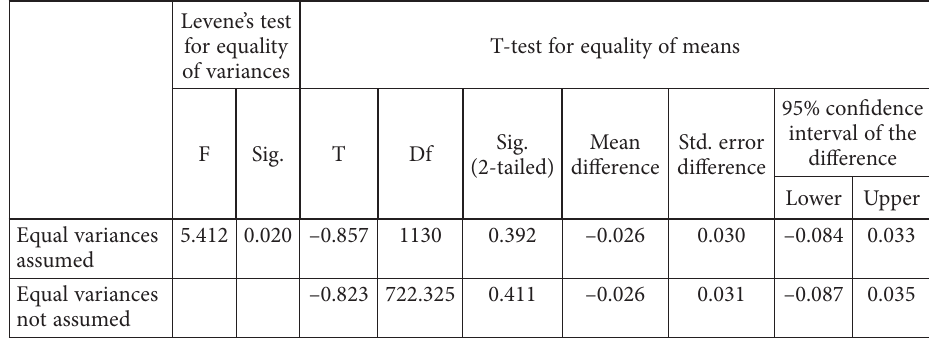
Table 4. T-test for independent samples among Jordan University of Science and Technology students due to gender (source: created by